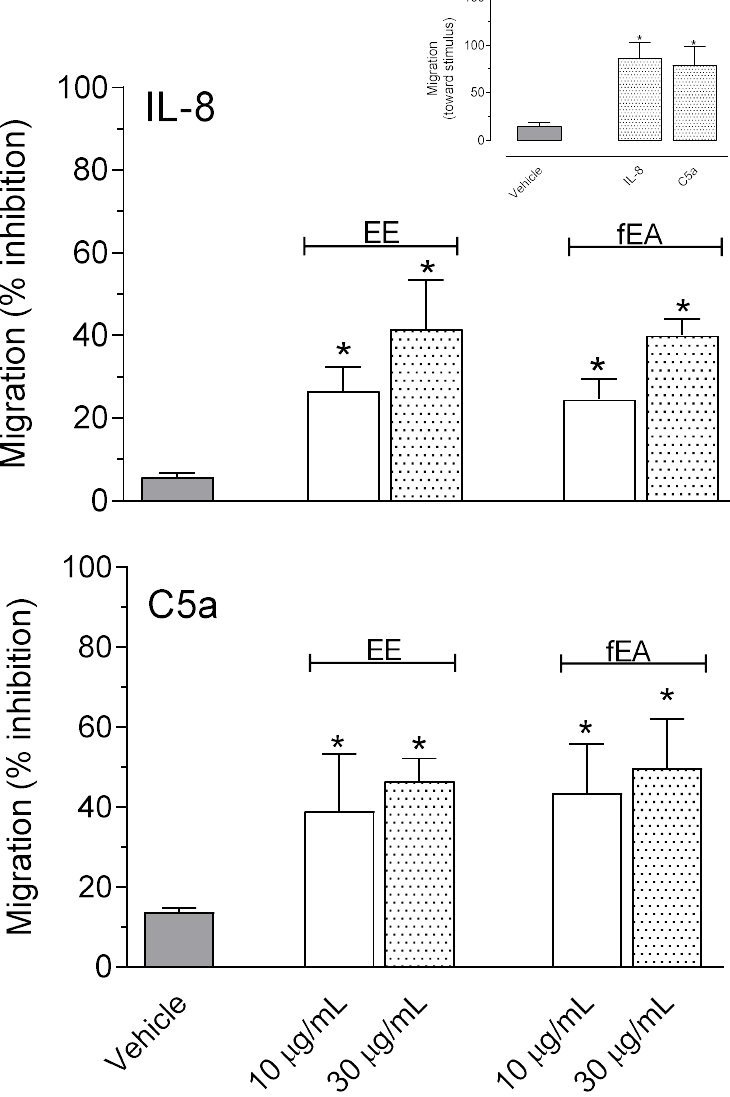
Figure 7. Effect of EE and fEA in reducing freshly isolated human polymorphonuclear cells (PMN) stimulated with IL-8 or C5a. PMNs were preincubated with EE or fEA (10 and 30 µ g/mL) and after that activated by IL-8 (10 − 7 M) or C5a (10 − 8 M). The insert shows the percentage of PMN that migrated toward saline, IL-8 or C5a as stimuli. The statistical significance was calculated using analyses of variance ANOVA followed by the post-test of Newman–Keuls. * p < 0.05 when comparing the cells that received EE or fEA with the vehicle or when comparing the cells that received IL-8 or C5a as stimuli with group receiving saline as stimuli (insert).